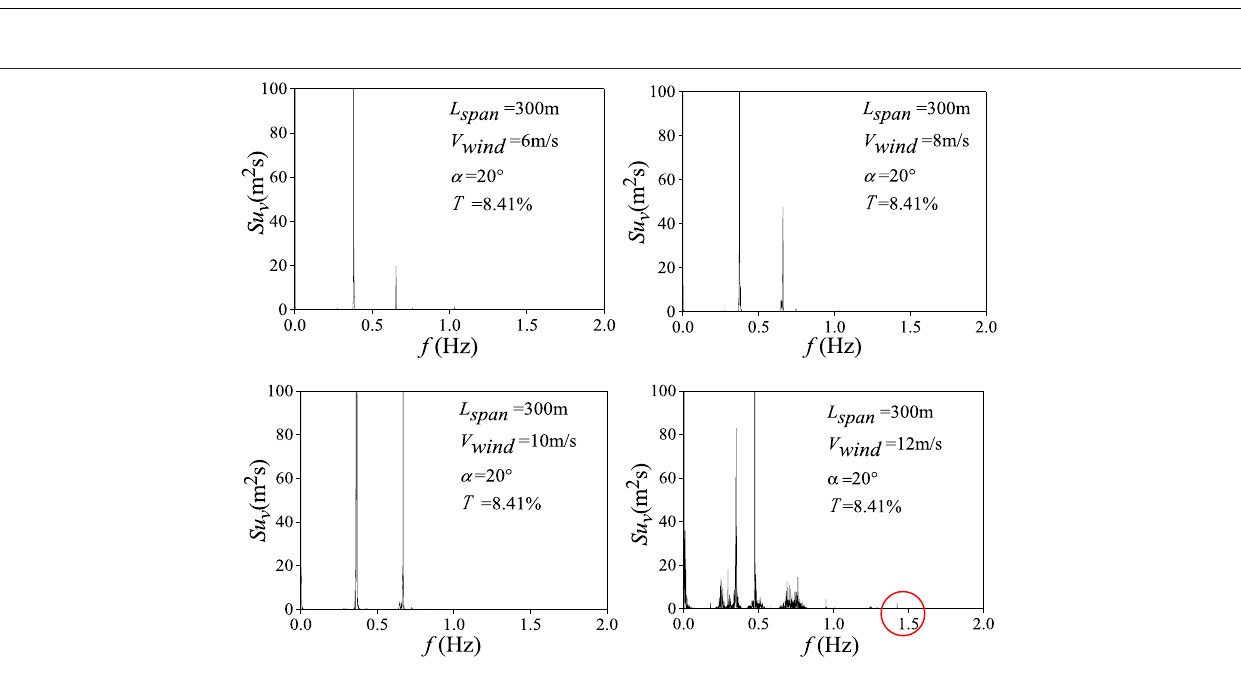
FIGURE 7 | Displacement spectrum under different wind velocities.